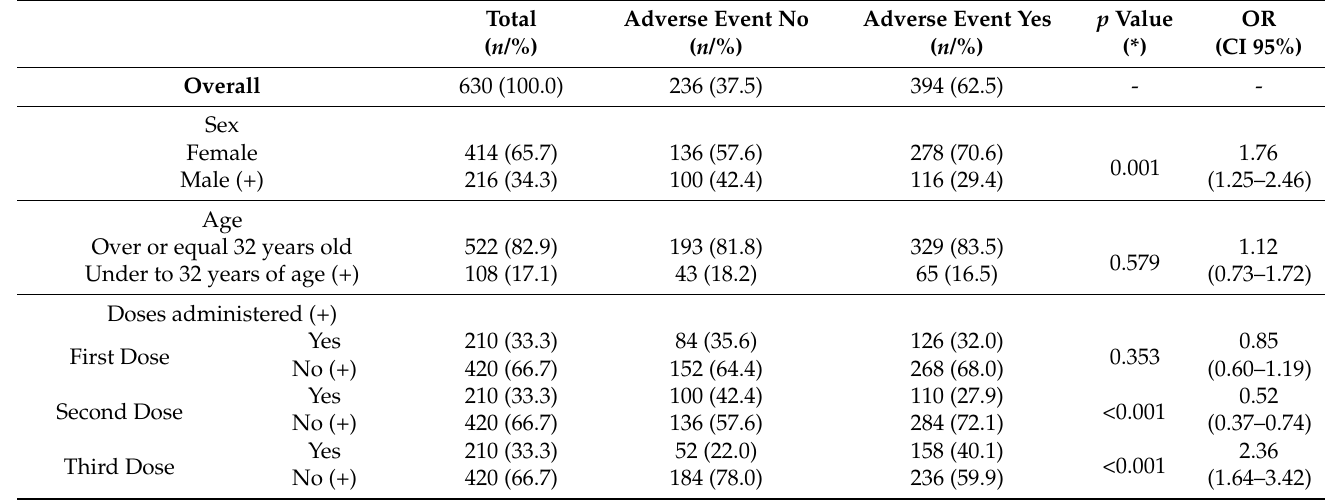
Table 5. Factors related to the development of adverse